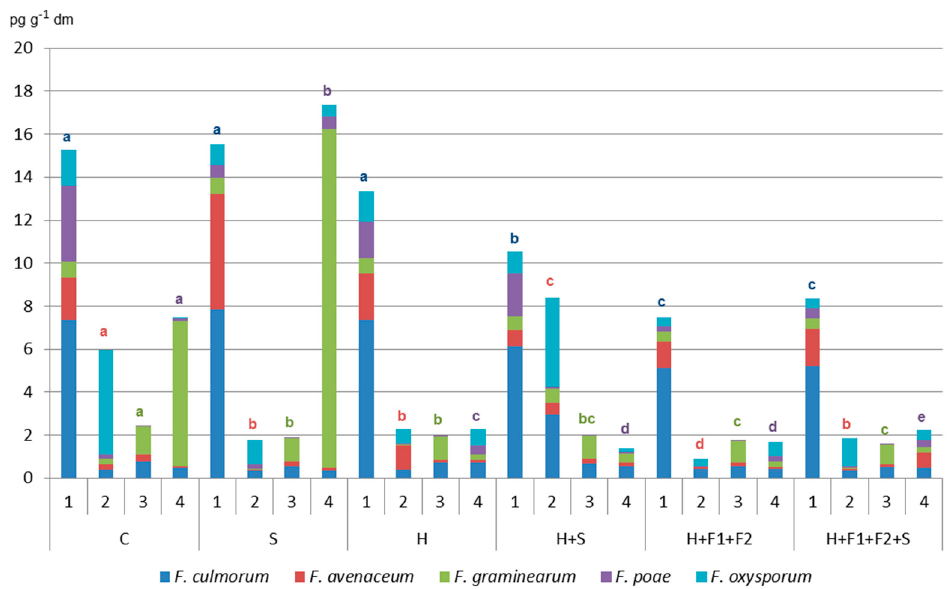
Figure 2. Concentration of Fusarium spp. in wheat grain in four years of the study (1—2017; 2—2018; 3—2019; 4—2020). C—Control; S—biostimulator; H—herbicide; F1—fungicide 1; F2—fungicide 2. Bars marked with the same letter do not differ significantly ( p ≥ 0.05) in the particular year of the study.